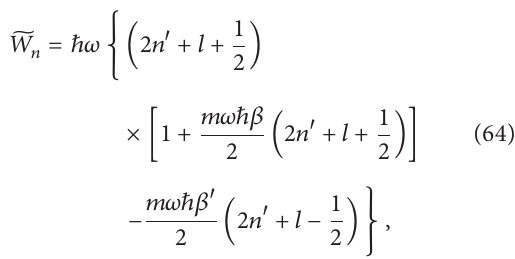
Figure 1: Splitting of degenerated energies in the presence of 𝛽 󸀠 . The value of (𝑛, 𝑙) , in turn from upper line, are (2,1), (3,2), (4,3), (5,4), and (6,5). We have taken 𝑗 = 𝑙 + 1/2 , 𝛽 = 0.001 , 𝑐 = 1 , 𝑚 = 1 , 𝜔 = 1 , and ℎ = 1 and all these values are chosen dimensionlessly for